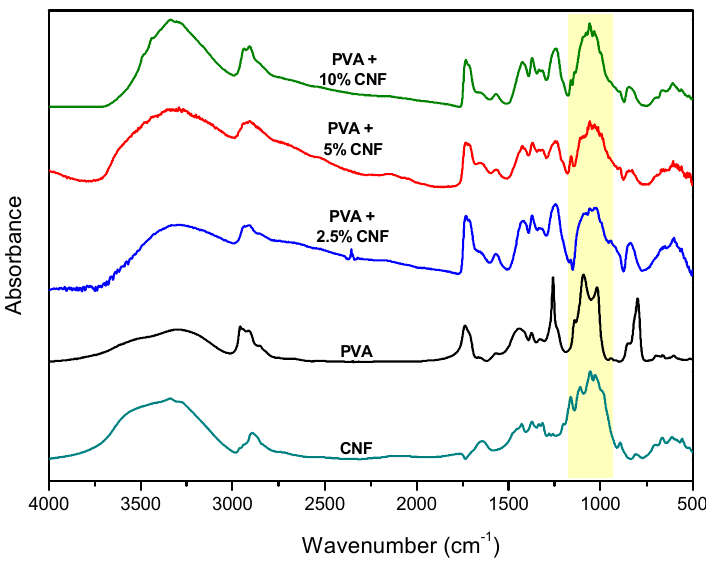
Figure 1. FTIR spectra of PVA/CNF sponges, compared with neat PVA and neat CNF.